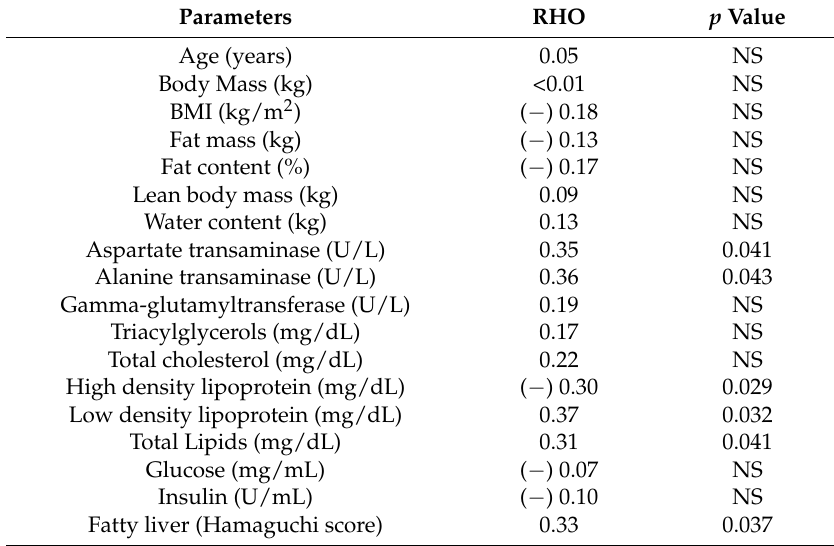
Table 3. Correlations between serum zonulin content and patient